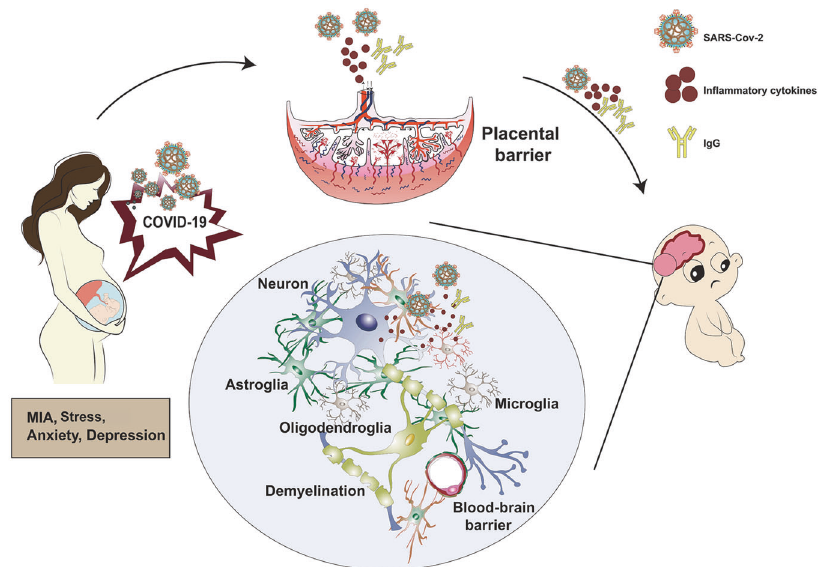
Fig. 1 Potential mechanisms of SARS-Cov-2 infection on the nervous system in the offspring during the pregnancy. MIA maternal immune activation.